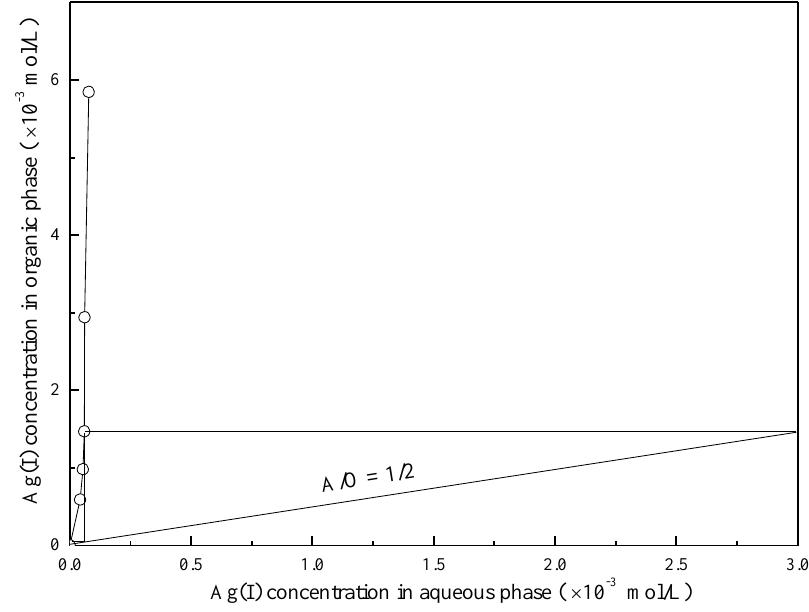
Figure 4. McCabe – Thiele plot for Ag(I) extraction using 2 mol/L LIX63.